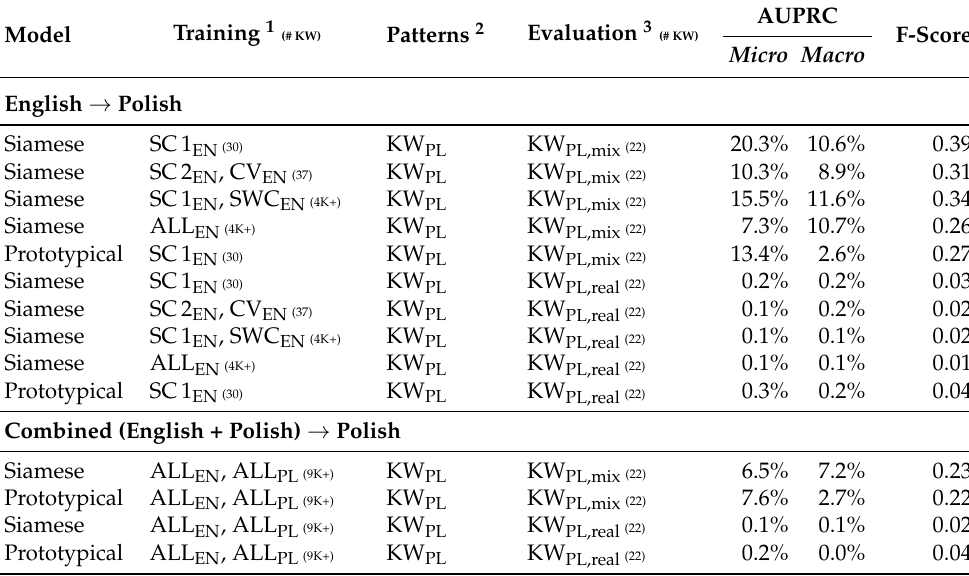
Table 5. Keyword detection performance for models trained and evaluated in cross-lingual scenarios. Metric values are reported in the same manner as in Table